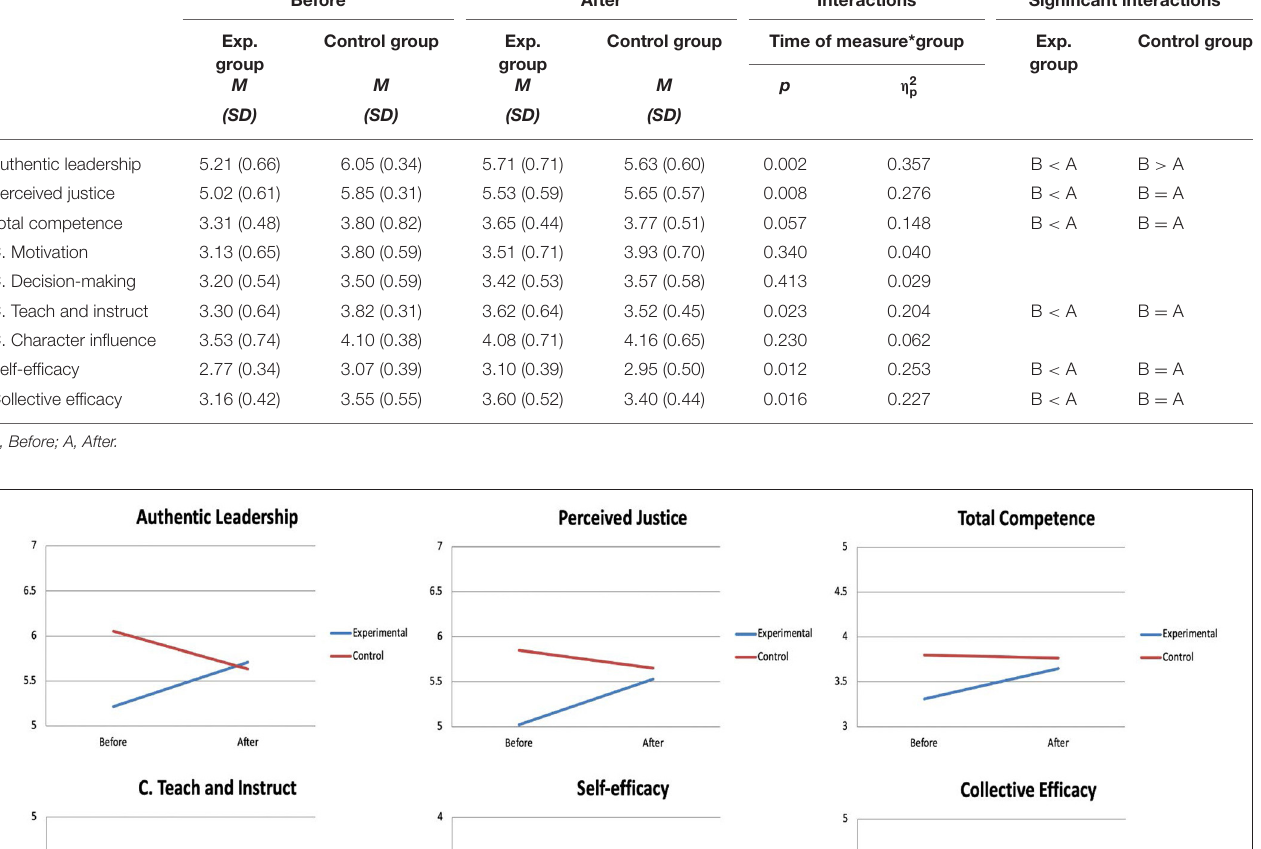
TABLE 2 | Means and standard deviations of the coaches in the experimental and control groups before and after the intervention, and interaction time of measure*group. Before After Interactions